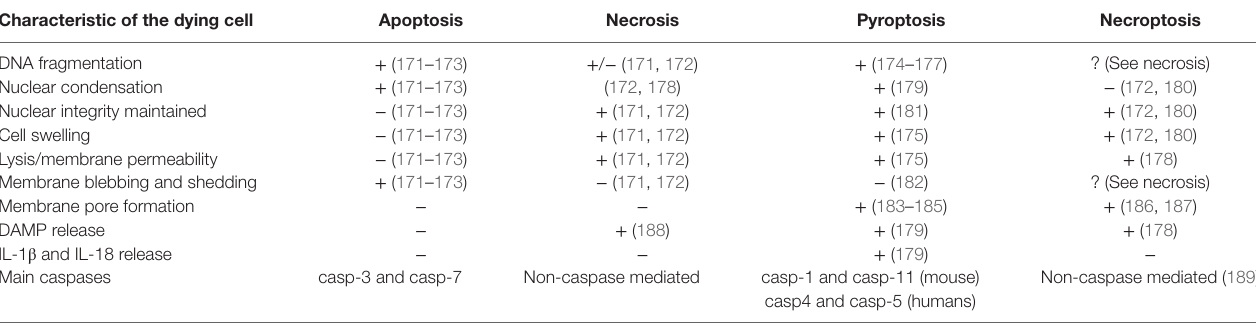
TabLe 4 | Characteristic features of different cell death